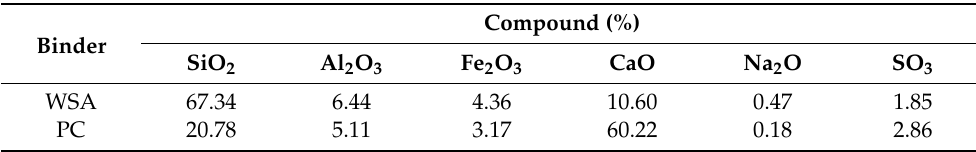
Table 1. Oxides composition of WSA and